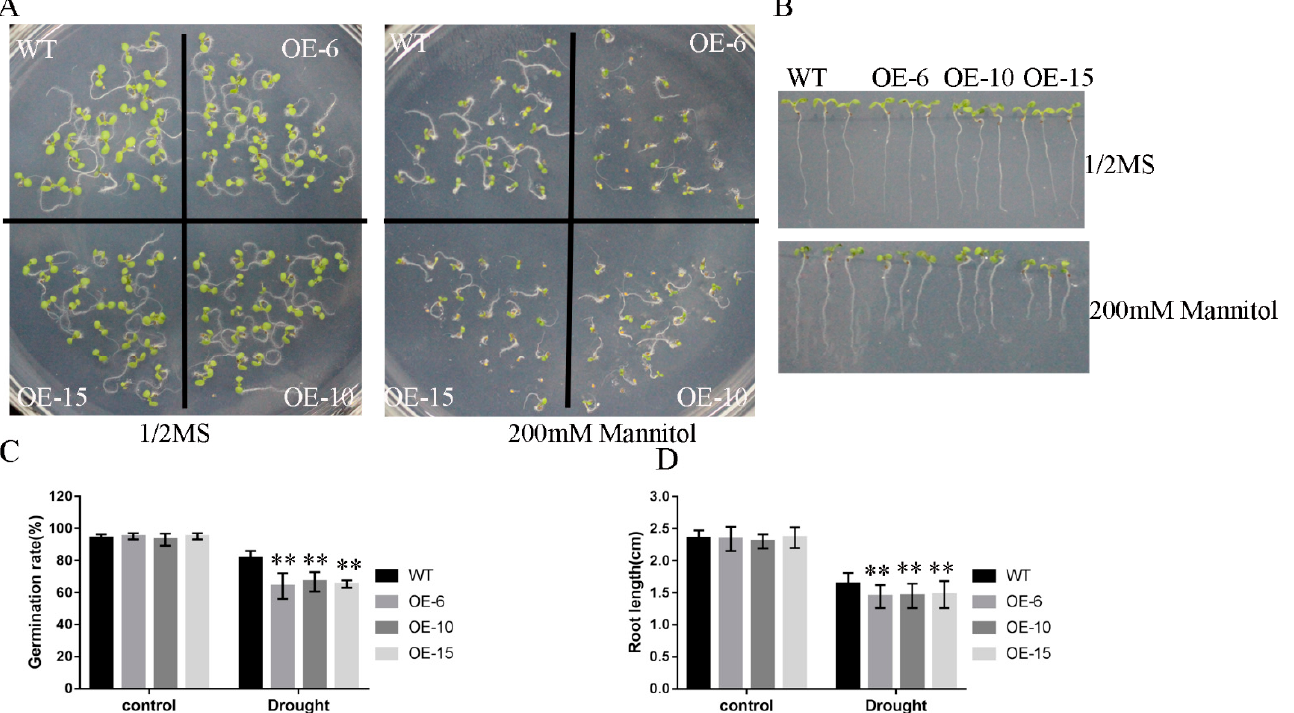
Figure 6. Drought stress responses of TaNBR1 -overexpressing transgenic Arabidopsis and wild-type plants. ( A ) Seedling growth by wild-type and TaNBR1 -overexpressing transgenic Arabidopsis plants under treatment with 200 mM of mannitol for 5 days. ( B ) Root length under the mannitol treatment. Surface-sterilized wild-type and transgenic Arabidopsis plant seeds were sown on 1/2 MS solid medium and incubated at 4 ◦ C for 3 days. The seeds were transferred from 1/2 MS medium to plates containing 1/2 MS and 1/2 MS with 200 mM of mannitol, and the images were acquired after 5 days. ( C , D ) Seed germination percentage and root length in wild-type and transgenic Arabidopsis plants. The data represent the mean ± standard deviation (n = 3), and the asterisks over the bars indicate the significant differences between the wild-type and transgenic Arabidopsis lines. ** t -test, p < 0.01.